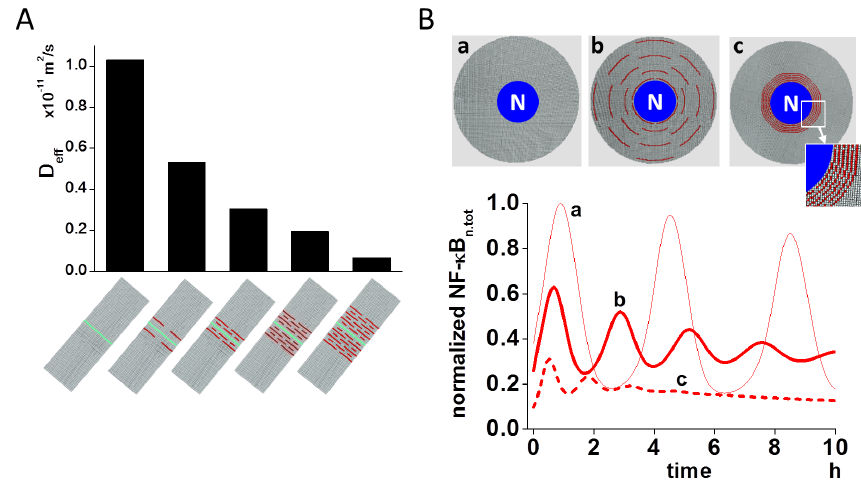
Figure 6. Organelle crowding around the nucleus alters the oscillation pattern of nuclear NF- k B. (A) Effective value of diffusion coefficient D eff was changed considerably by the addition of diffusion obstacles (short and long red lines). All diffusing substances were concentrated at the center (green line) at t=0 . D for all simulations was 10 2 11 m 2 /s, irrespectively of the presence or absence of diffusion obstacles. However, D eff was reduced by more than one order of magnitude by the increase in the population of diffusion obstacles. (B) The change in the oscillation pattern by the organelle crowding around the nucleus. Oscillation patterns were compared with three different densities of organelles. Oscillation pattern of NF- k B n.tot without organelles is shown by thin red line (a). If organelles were added, the oscillation was heavily dampened (b, thick red line). If the organelles were crowded around nucleus, virtually no oscillation was observed (c, broken red line). Concentrations were normalized to the maximum value without organelles (case a).